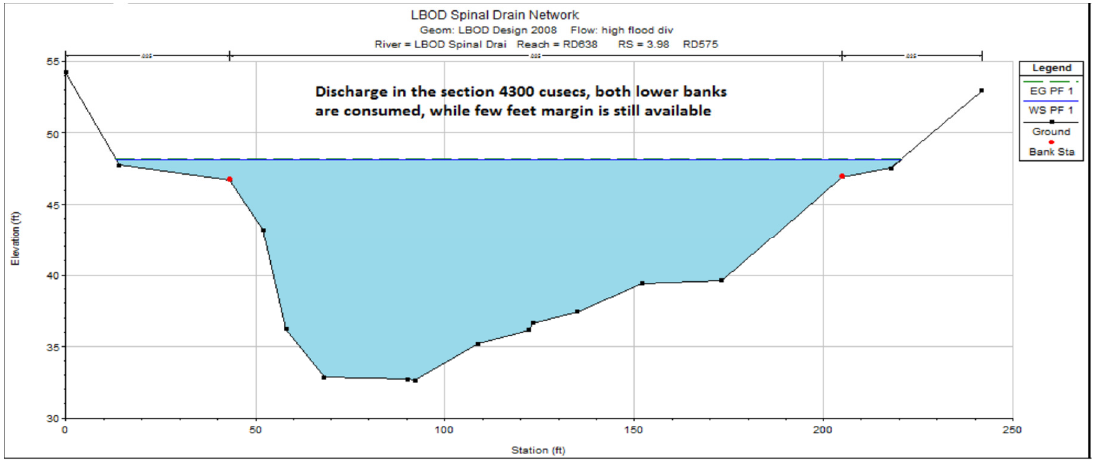
FIG. 5. CROSS SECTION OF RD-575 OF LBOD (SIDA STUDY 2012)